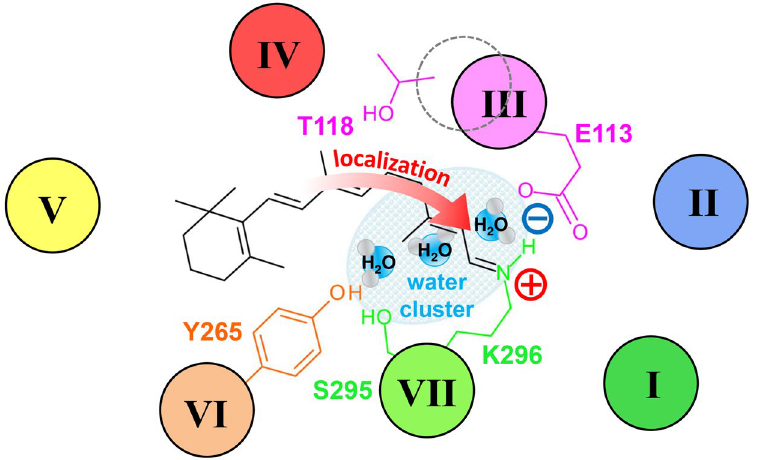
Figure 6. Structural model of the retinal binding pocket in MB that leads to the spectral blue-shift of λ max . MB- specific water cluster is situated in the vicinity of retinal Schiff base using a unique hydrogen bonding network with two key residues: Y265 and E113. Consequently, π -electrons along the polyene chain is highly localized towards the protonated Schiff base, which causes the spectral blue-shift of λ max in